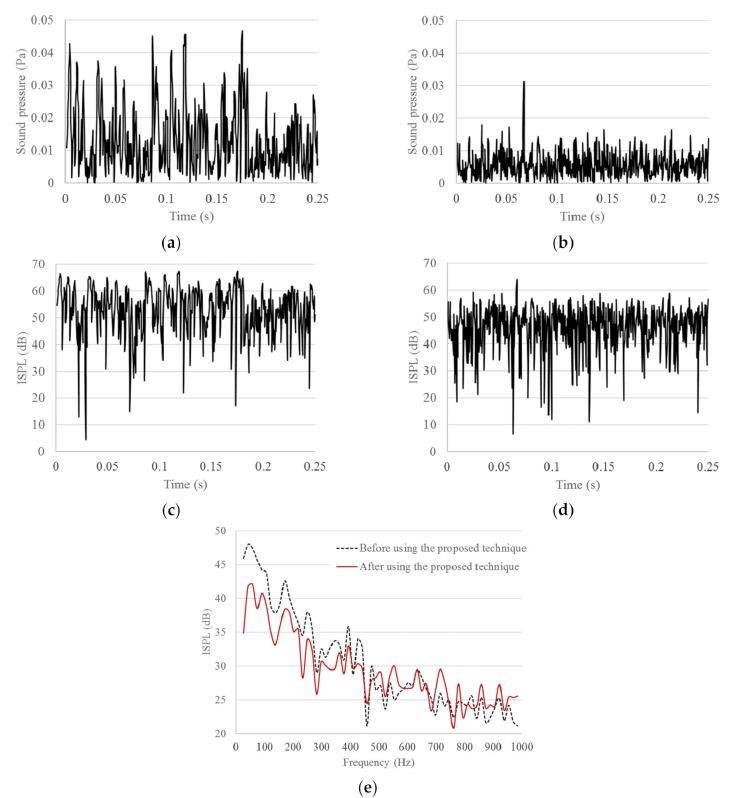
Figure 12. Broadband noise obtained: ( a ) sound pressure at the measurement point before using the rings; ( b ) sound pressure at the measurement point after using the rings; ( c ) ISPL of the noise before using the rings; ( d ) ISPL of the noise after using the rings; ( e ) frequency spectra of the ISPL data obtained in the two